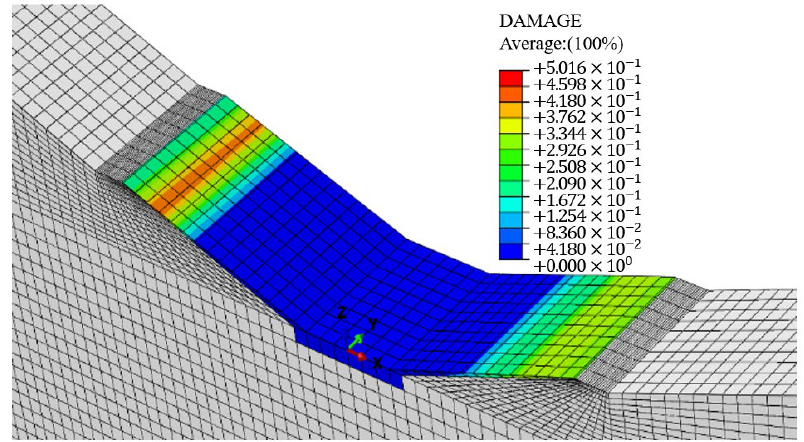
Figure 20. Damage-distribution cloud diagram after 50